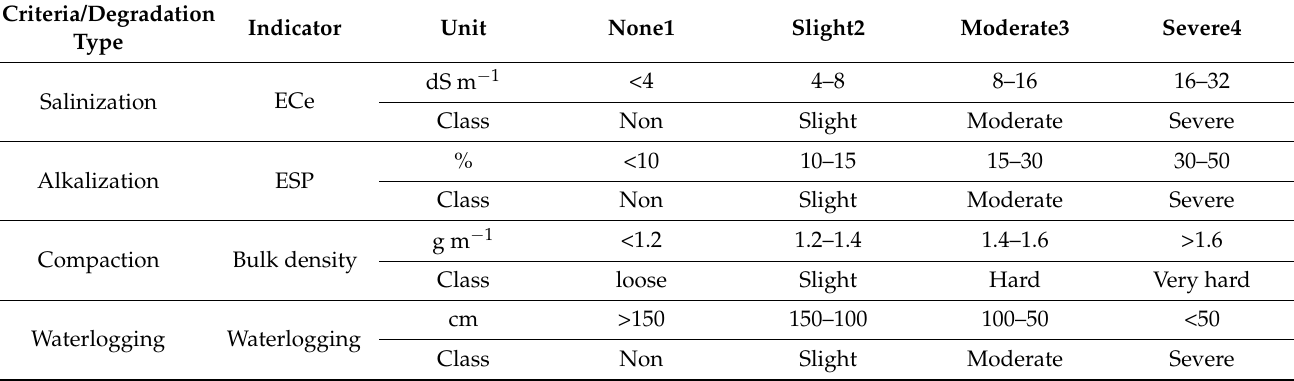
Table 2. Criteria used to determine the degree of different types of degradation after FAO/UNEP